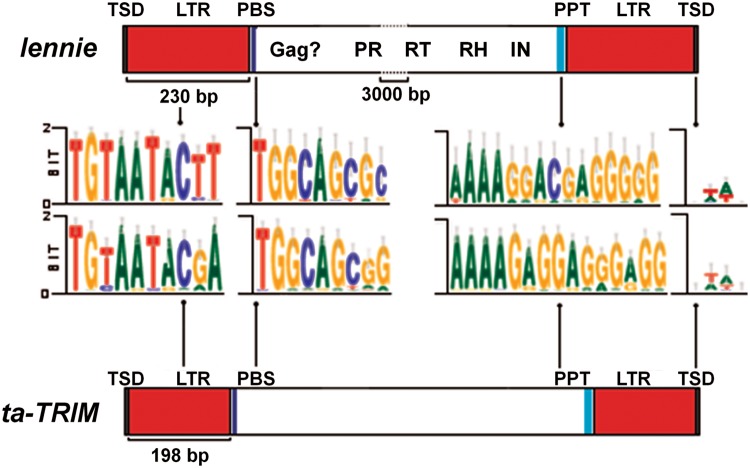
Comparison of ta-TRIMs and lennie elements. Diagrams to scale of idealized ta-TRIM and lennie elements from E. multilocularis, and direct comparison of sequence logos of selected features from both elements (from left to right, the 5′ of the LTR, the PBS, the PPT, and the TSD). Logos were created from sequence alignments of ta-TRIMs or lennie elements with WebLogo 3.4 (Crooks et al. 2004). In addition to PR, RT, RH, and IN domains, there is an upstream ORF in lennie that could code for Gag but does not show similarity to any sequences outside flatworms (data not shown).